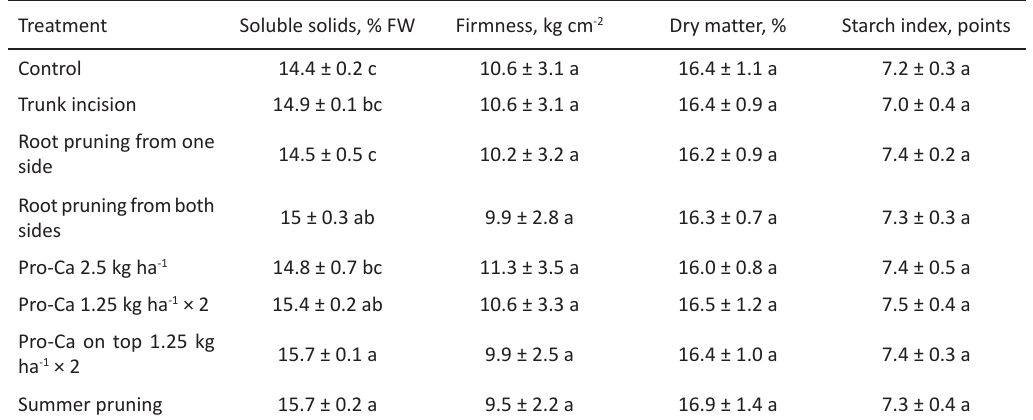
Table 4. Effect of growth control technologies on chemical composition of apple fruits, average of